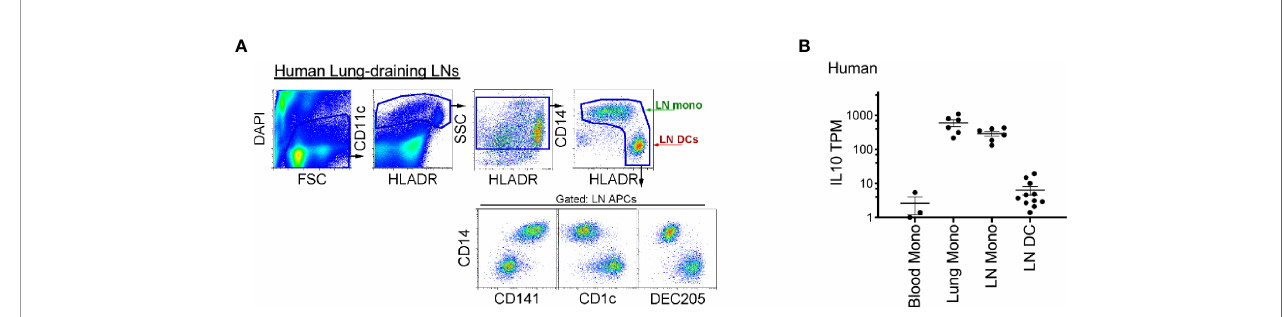
FIGURE 7 | Compared to LN DCs, human lung and lung-draining LN monocytes express IL-10. (A) Top, fl ow cytometry gating strategy to identify human lung- draining LN monocytes and DCs: live cell gate, DAPI - , followed by CD11c + cells and intermediate-high side scatter with the fi nal HLADR +/high APC gate: displaying CD14 + CD141 low/+ monocytes and DC subsets (CD14 - CD141 - , CD1c + , DEC205 + ). Flow plot is representative of over 30 human LLNs analyzed (36, 40). (B) RNA sequencing, transcripts per million (TPM) of monocytes and DCs sorted from human blood, lung and lung-draining LN (40). Data are shown as mean